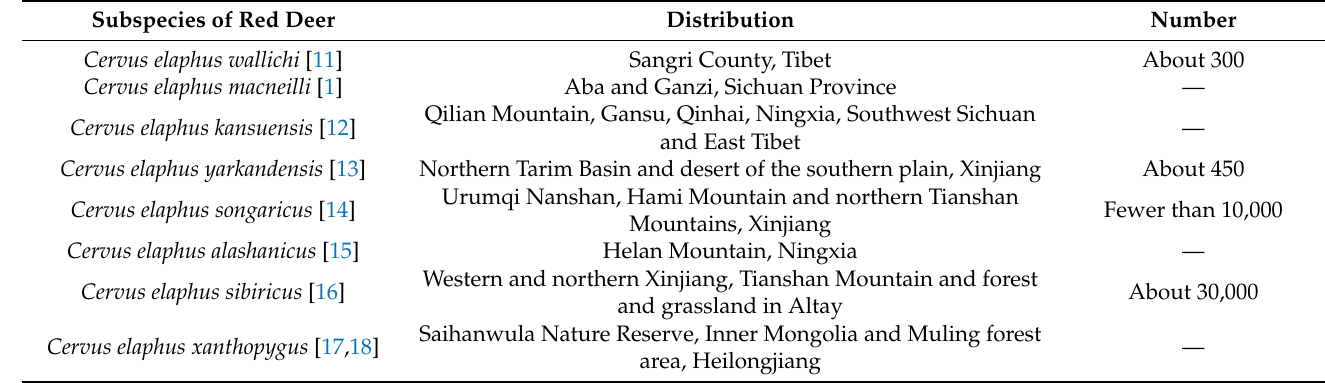
Table 2. Distribution and number of subspecies of wild red